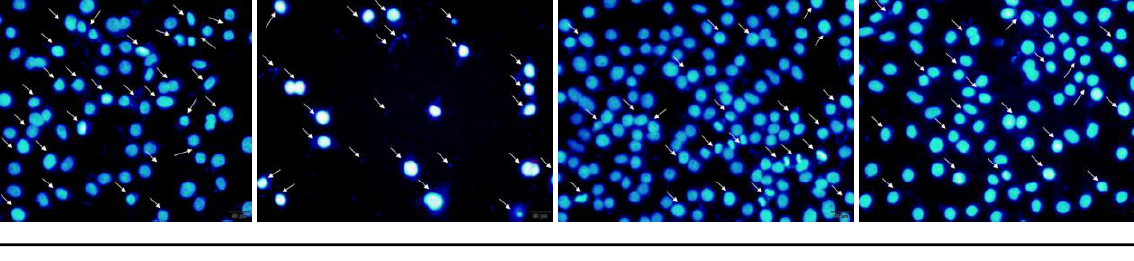
Figure 6. Representative fluorescence immunocytochemistry of HepG2 cells exposed to tamoxifen, naringenin and quercetin. Cells were stained with DAPI after treatment with tamoxifen (20 μM ), naringenin (10 and 200 μM ) and quercetin (10 and 100 μM ) alone or in combination for 24 h. Then, cells were scrutinized for nuclear morphology at 400× magnifications, and the white arrows ( → ) indicate chromatin condensation and fragmentation in apoptotic cells.